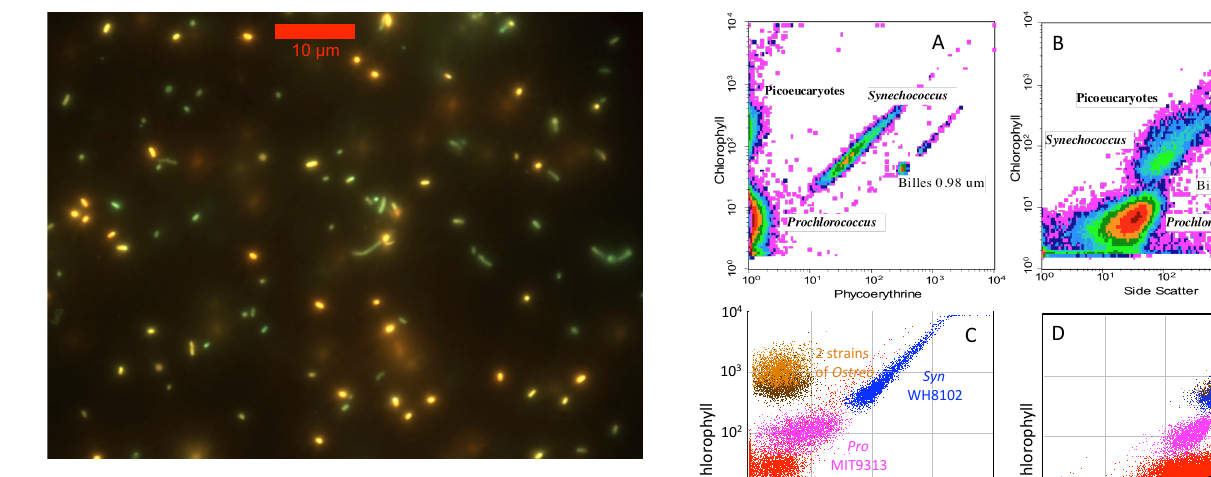
Fig. 4. Cells from a Syn culture kept at − 30 ◦ for 1yr and then sub- jected to a live/dead staining procedure. Cells with a yellow-green colour survived with membranes intact; membranes of cells with a red colour lost their integrity and are regarded as dead. Scale bar is 10µm.